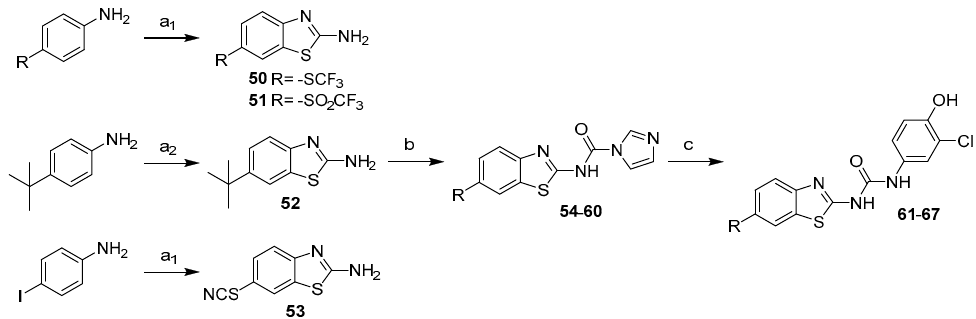
Table 4. Fourth series of prepared compounds ( 71 – 78 ).